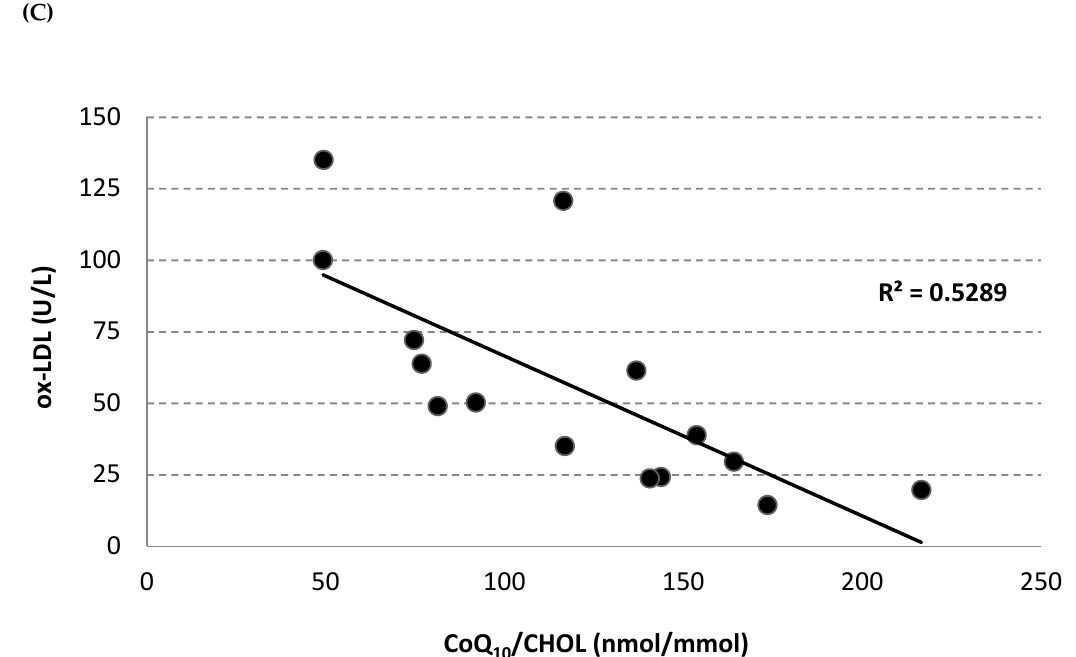
Figure 4. Plasma oxidized LDL level (U/L) ( A ) at baseline, after 2 and 4 weeks of Afriplex GRT treatment, and following 1 month-wash-out in non-diabetic (black) and diabetic (grey) vervet monkeys. Correlation between plasma oxidized LDL level and both total LDL ( B ) and CoQ 10 /Chol level ( C ) in diabetic monkeys in baseline, after 4 weeks of supplementation and wash-out period. * p < 0.05 comparing different experimental points for each group; # p < 0.05 ## p < 0.01 comparing both groups for the same experimental time point. b = 4 weeks-treatment.